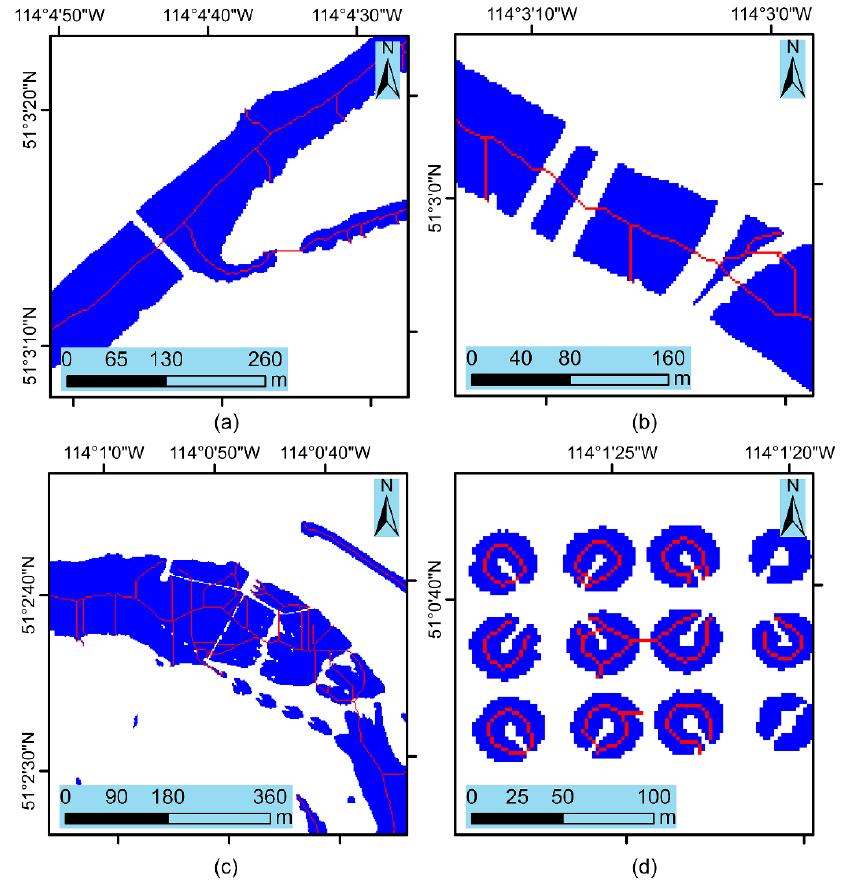
Figure 6. Four examples of river segment connection scenarios. The blue mask is the river segments, while the over-draped red lines are centerlines extracted from the new water mask after image pyramid. ( a ) and ( b ) Simple scenarios: river segments discontinued by bridges; ( c ) Difficult scenario: river segments discontinued by a dam and waves; ( d ) Incorrected scenario: sewage treatment